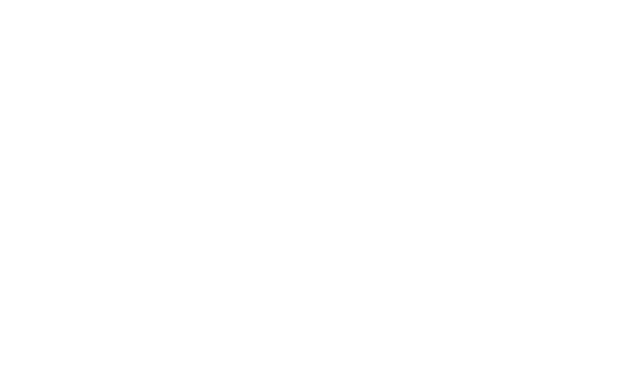
FIGURE 6 | Structure of α -methyl-branched-chain fatty acyl-CoA esters.